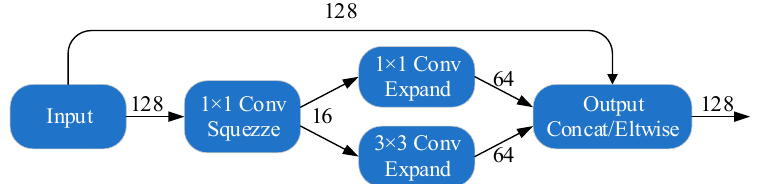
Figure 8. Proposed residual Squeeze Net architecture with simple bypass connections.